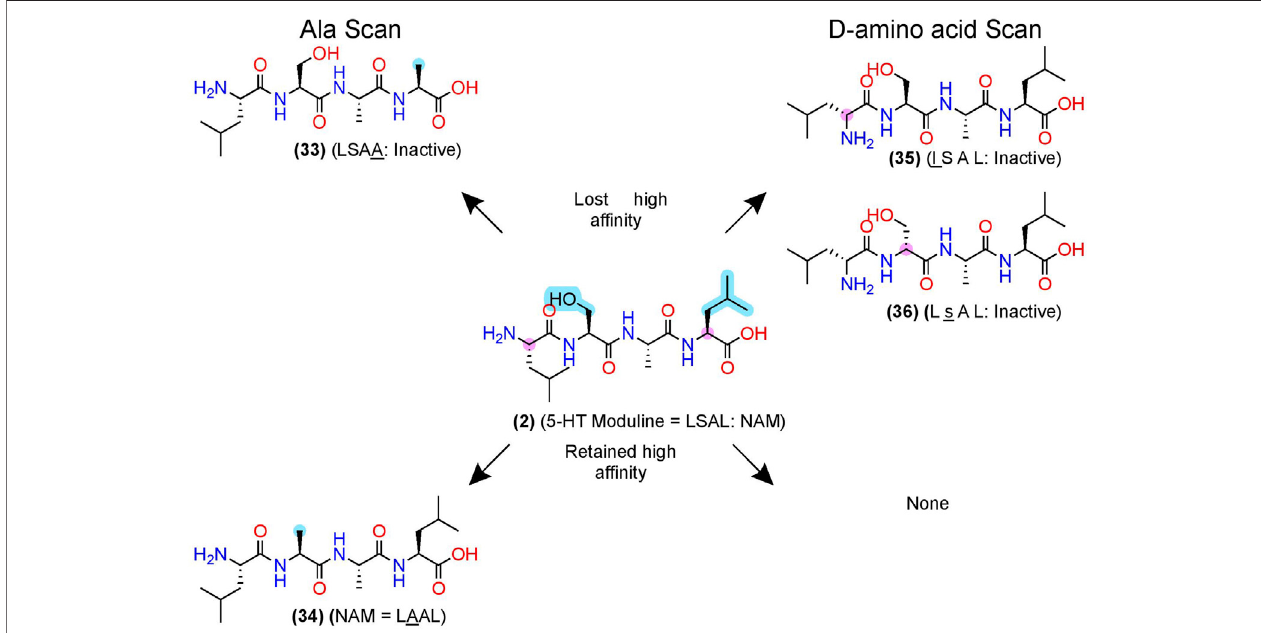
FIGURE7| D-aminoacidandalaninescansfora5HT 1B NAM — 5-HT-moduline. (Left) thekeypharmacophorefeaturesarehighlightedinyellowasdeterminedvia an alanine scan. (Right) D-amino acid scan. (Top) examples of modi fi cations that lost NAM function or (bottom) retained NAM activity. Structures from Plantefol et al. (1999). Uppercase letters indicate L-amino acids, and lowercase letters represent D-amino acids. The in-text compound number is bold (original name: activity). Sidechain pharmacophore features are labeled in cyan and backbone features labeled in pink. Figure was created with Chemdraw20.0.